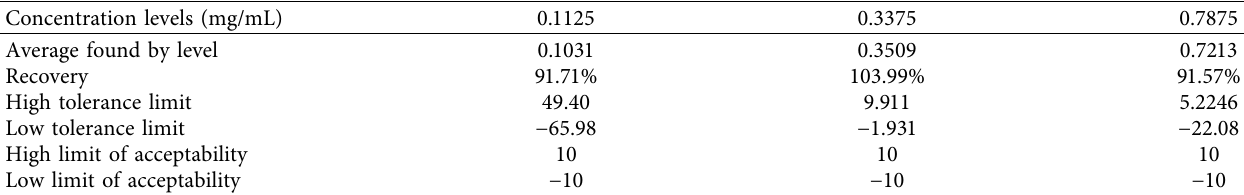
Table 8: Accuracy data obtained with the polynomial function and the